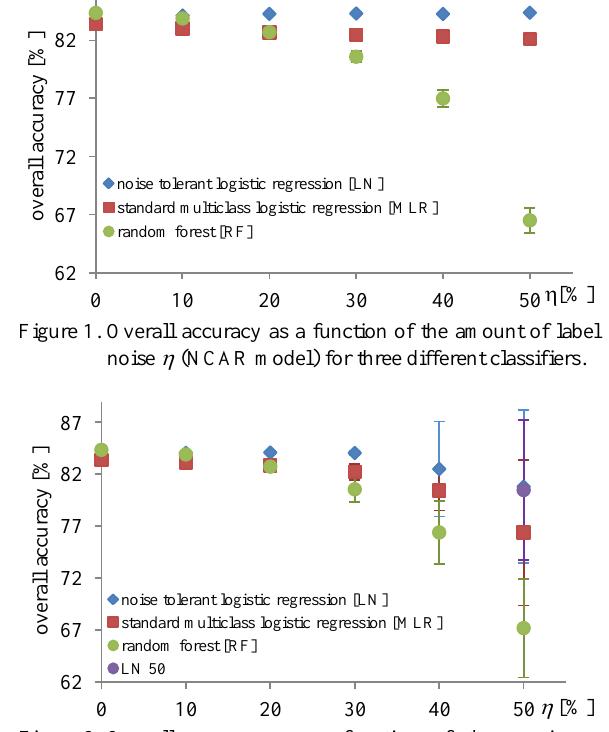
Figure 2. Overall accuracy as a function of the maximum amount of label noise  (NAR model). Note that LN50 was only tested for  =